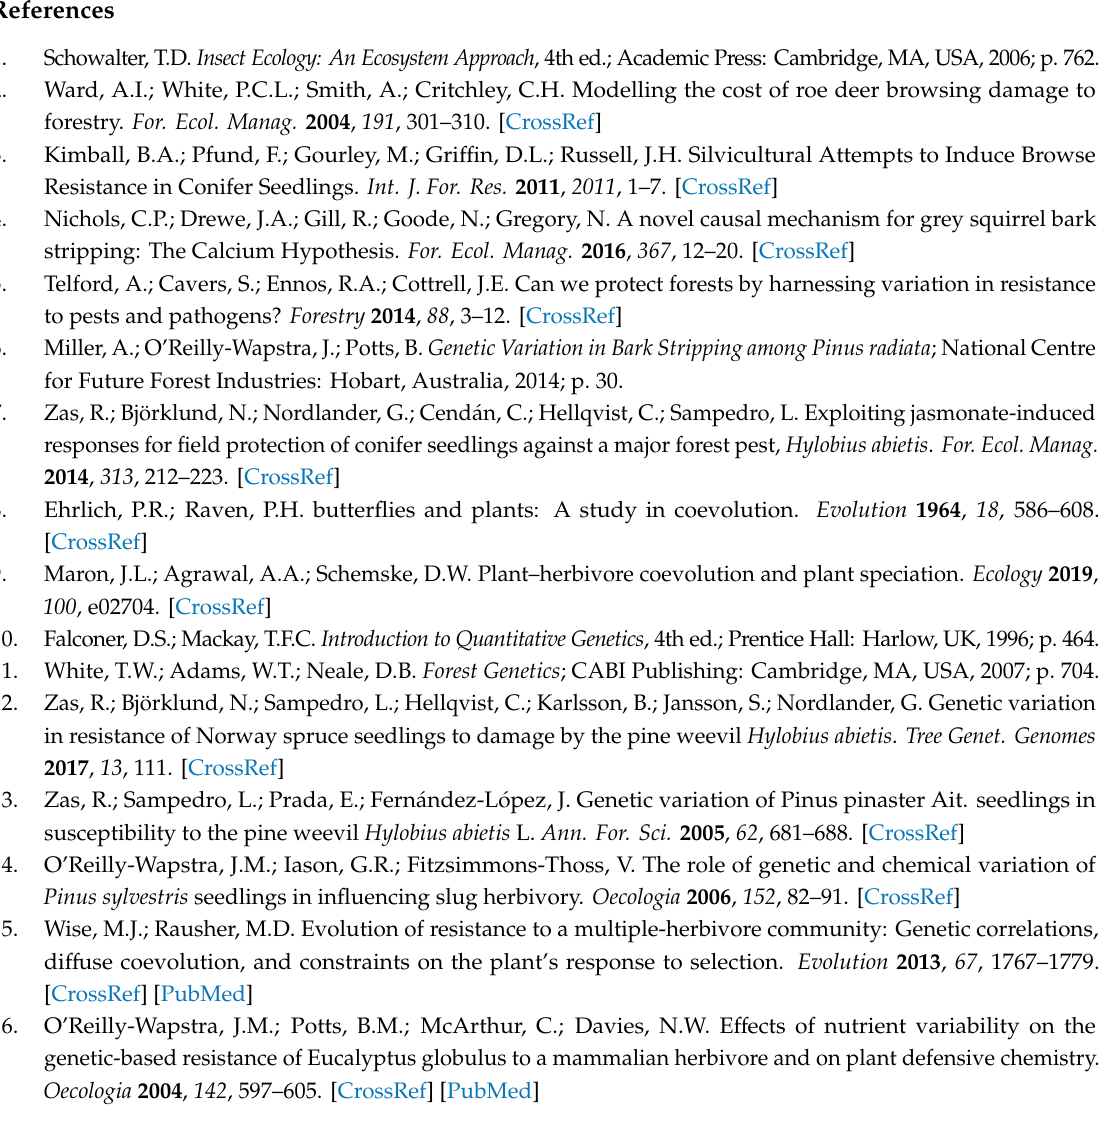
Figure S1: Heat maps of bark stripping scores from the three field sites based on assessments for year 5 (2016) at Beulah and Payanna and for year 2 (2017) at Wilmot, Figure S2: Semivariograms of the residuals generated from the spatial models showing the small-scale spatial variation in bark stripping (above) and height (below) for (a) Beulah, (b) Payanna. and (c) Wilmot after adjusting for random genetic, replicate. and incomplete blocks within replicate e ff ects using mixed models. If spatial dependence is present, semivariance will be small at short distances, will increase at intermediate distances, and will reach an asymptote at longer distances. Estimates are based on assessments at year 5 (2016) at Beulah and Payanna and at year 2 (2017) for Wilmot, except for the height variogram for Payanna that used the year 4 height, since only one height measurement was taken for this